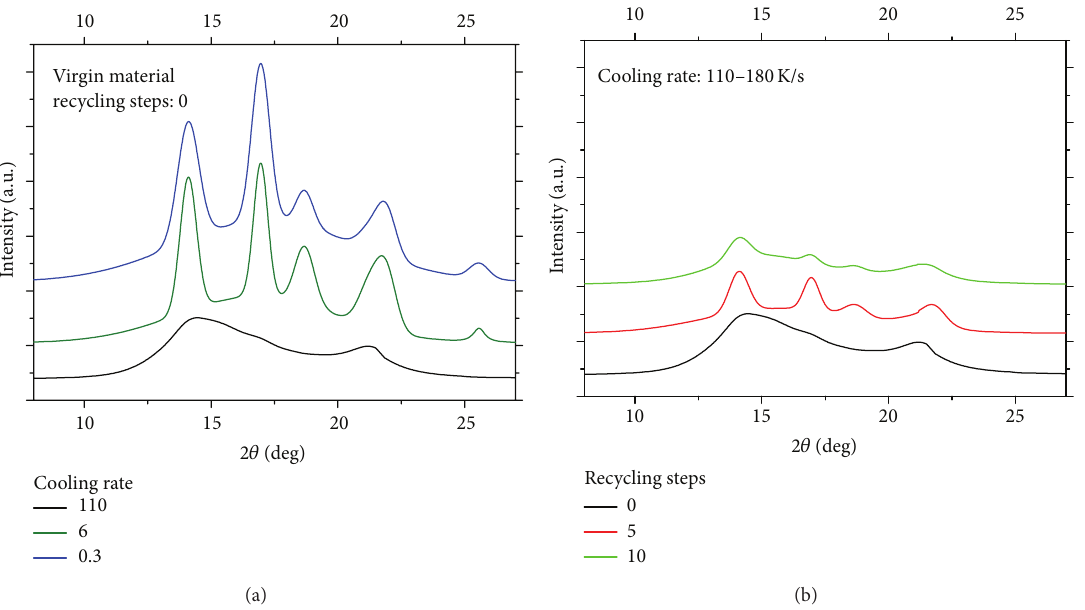
Figure 5: WAXS spectra of the samples of virgin material solidified at different cooling rates in the (a) plot and WAXS spectra of the samples solidified at the highest applied cooling rates in the (b) plot.